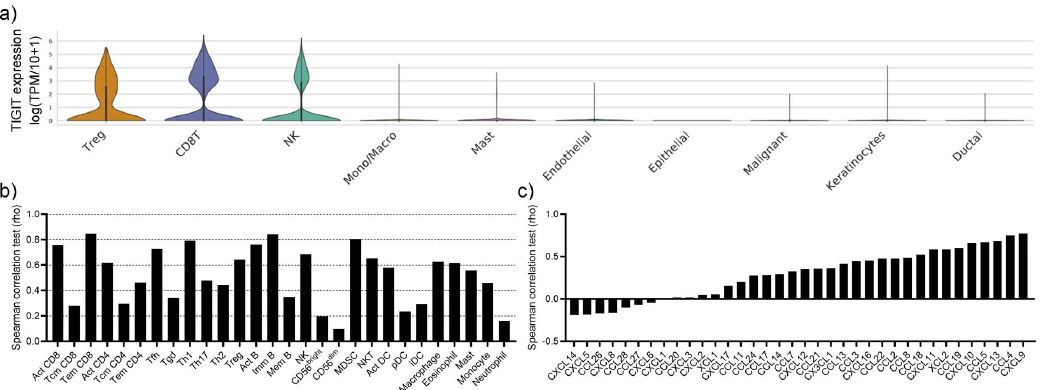
Figure 1. ( a ) Cellular TIGIT gene expression levels in single‑cell sequencing data of six patients with OSCC. ( b ) Correlation of TIGIT gene expression levels with immune cell infiltration. ( c ) Correlation between chemokines and the TIGIT gene expression